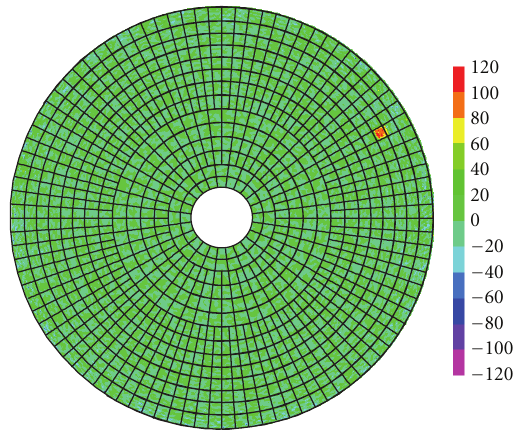
Figure 12: Map of the retrieved reflector surface for a deformation of 100 μ m of the panel under test. SNR = 56 dB. The color bar is in unit of μ m.